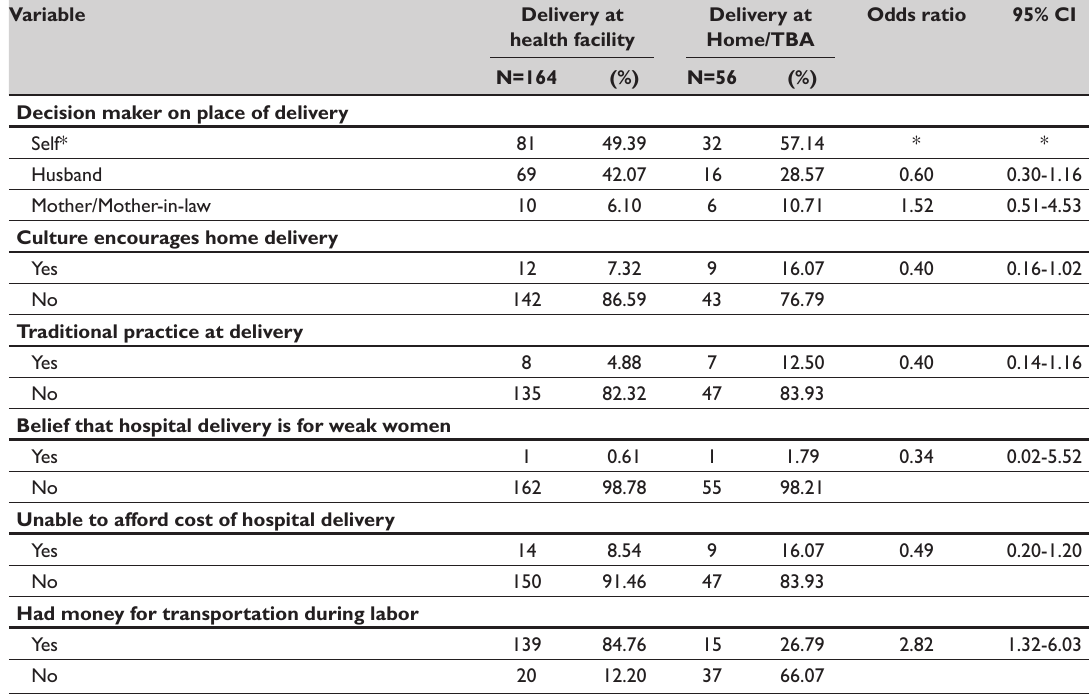
Table 4: Sociocultural and economic factors on choice of health facility delivery Variable